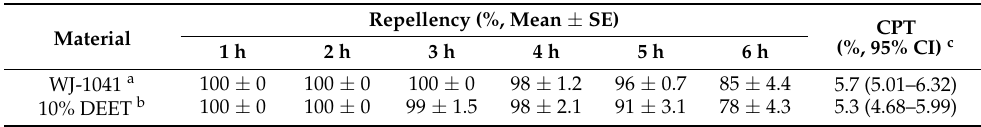
Table 7. Repellency and CPT of WJ-1041 containing 10% veratraldehyde as the active ingredient against Aedes albopictus females using the indoor test.